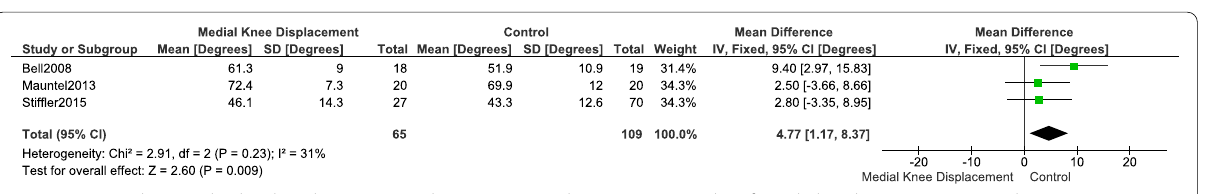
Fig. 6 Meta-analysis results detailing the association between external rotation ROM and 2D frontal plane knee projection